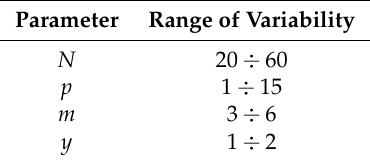
Table 1. Parameter Variation for the Determination of D . U .% and σ 0